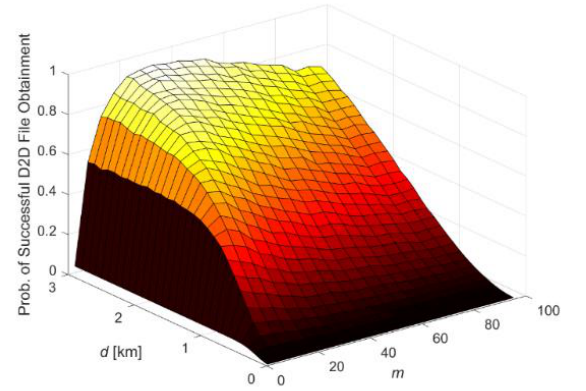
Figure 2. The probability of finding a file from the cache-enabled D2D UEs vs. the maximum allowable D2D distance (i.e., d ) and the number of network cache files (i.e., m ). Here, the z value is set to 10.